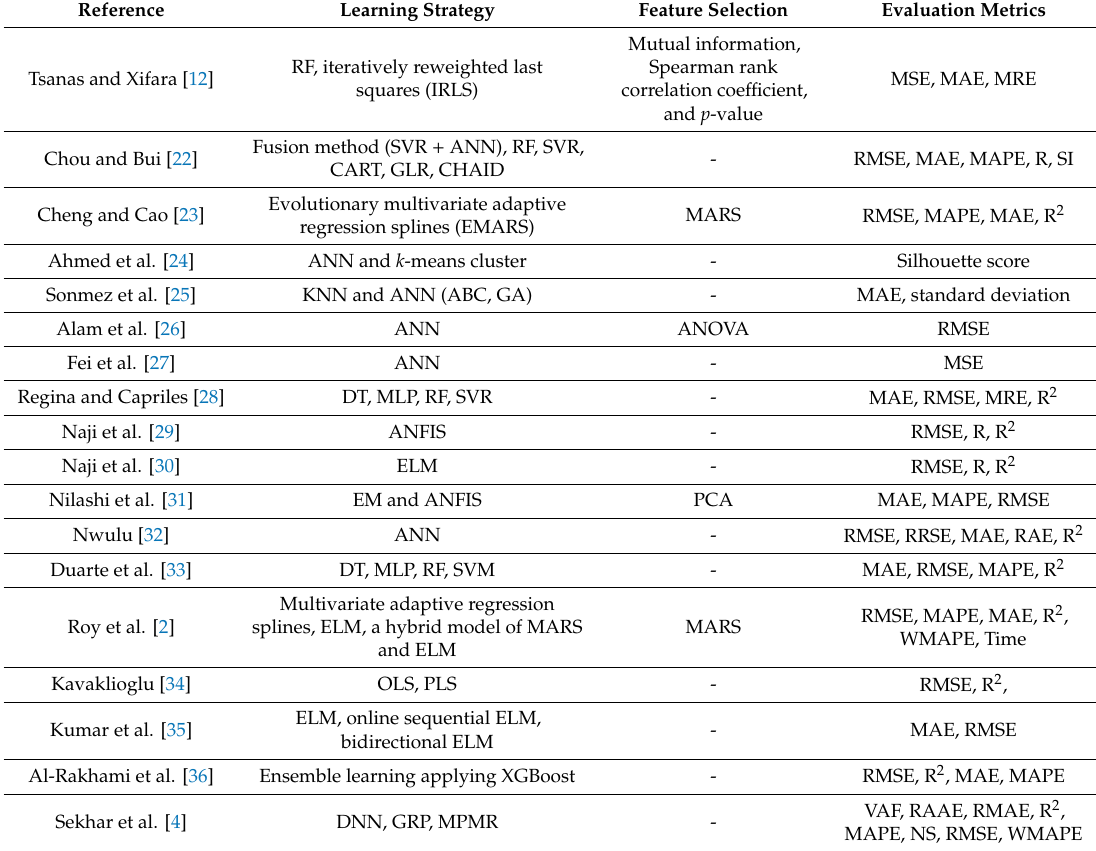
Table 1. Existing approaches for the prediction of HL and CL using energy e ffi ciency